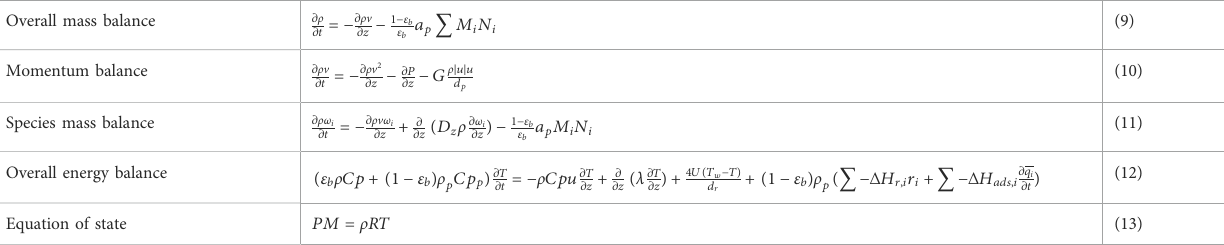
TABLE 1 Reactor model equations. Overall mass balance Momentum balance